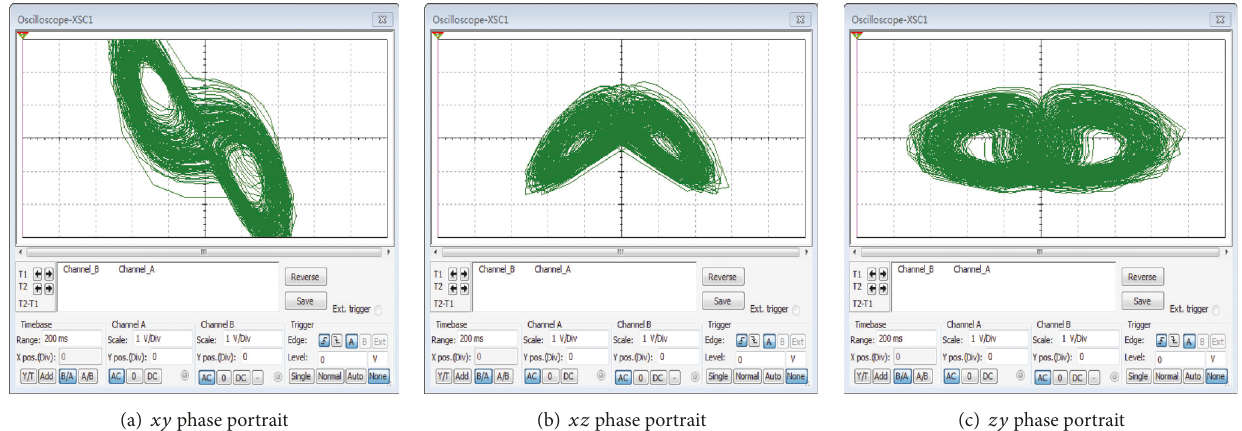
Figure 4: Chaotic phase portraits of the Lorenz-like chaotic circuit with reduced number of amplifiers.